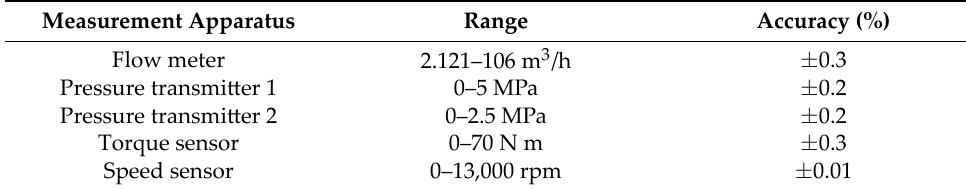
Figure 1. Test system: ( a ) Test rig. ( b ) Multi‑stage PAT and ECD. Table 3. Measurement apparatus’s range and accuracy.